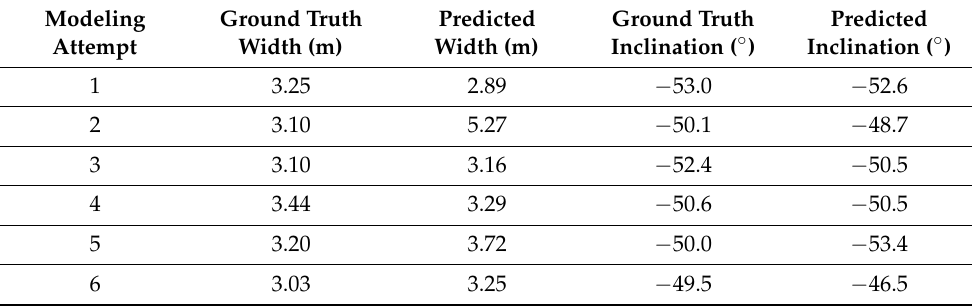
Table 6. Results of modeling extraction